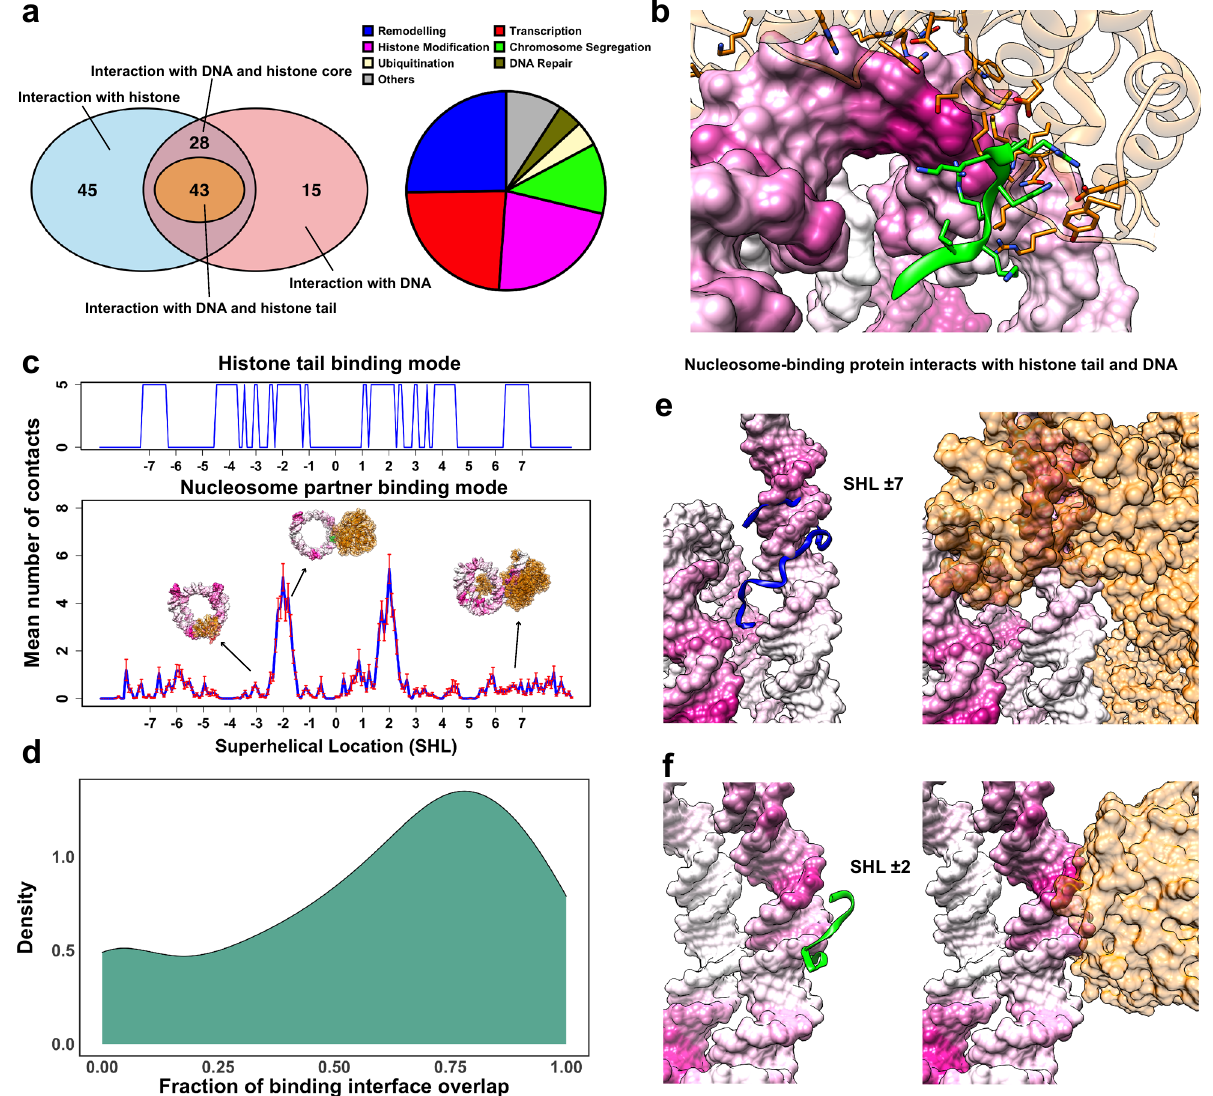
Fig. 3 Histone tail-modulated recognition modes of nucleosomes by binding partners. a A summary of 131 available nucleosome complex structures classi fi ed based on their binding entity and function. b An example of chromatin remodeler ISWI which binds to both histone H4 tail and DNA (PDB: 6IRO). Here coordinates of histone tails are taken from the PDB structure. Nucleosome-binding proteins are colored in orange and histone tails are colored using their canonical colors. c Analysis of the contact numbers between the nucleosomal/linker DNA and partners (averaged over all structures of nucleosome complexes) plotted in DNA coordinate frame. The error bars represent standard errors calculated from the number of contacts of different nucleosome complex structures ( n = 86). The top track shows the presence or absence of fi ve or more contacts between histone tails and DNA regions (indicating the histone tail preferred binding regions). d The fraction of interface overlap between tail – DNA and partner – DNA binding interfaces. It is calculated for each nucleosome complex structure and the distribution is smoothed using the gaussian kernel function. e , f Examples of INO80 chromatin remodeler (PDB: 6HTS) and UV-damaged DNA-binding protein (PDB: 6R8Z) targeting overlapping regions on DNA. Histone tail representative conformations are taken from simulations and superimposed onto the PDB structures. The intensity of the color of the DNA surface is scaled with the mean number of contacts between histone tails and DNA as in Fig. 2b. Source data are provided as a Source Data fi